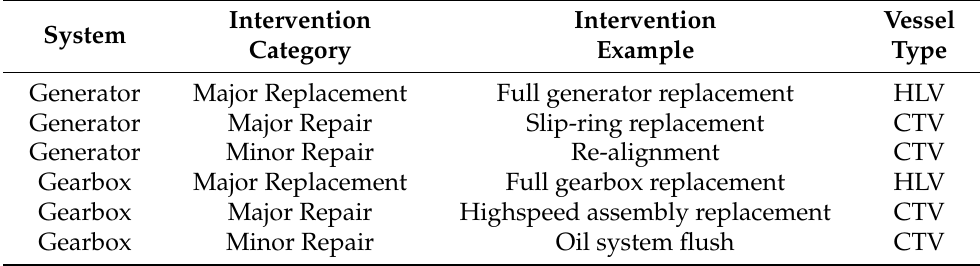
Table 2. Intervention